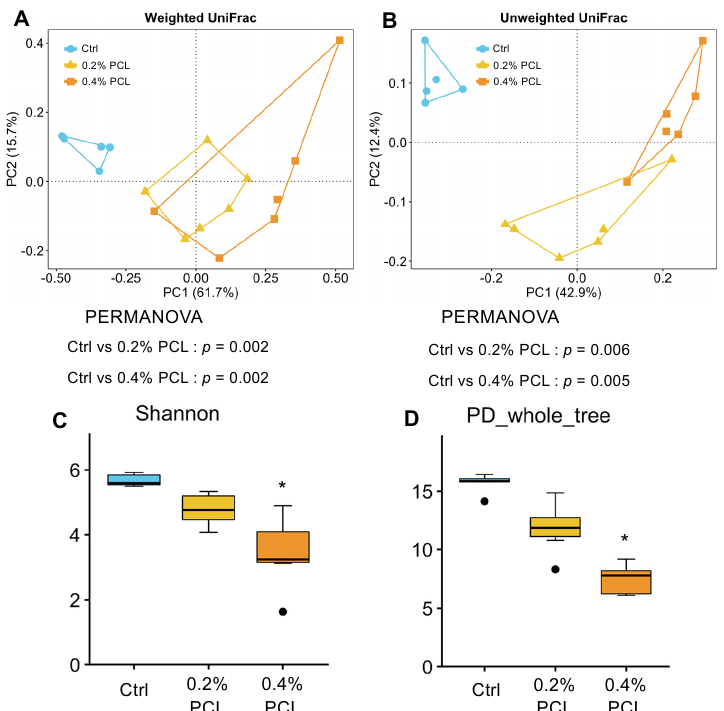
Figure 1. Effects of supplemental PCL on cecal microbiome profiles and alpha diversity. PCoA of unweighted ( A ) and weighted UniFrac ( B ) and PERMANOVA analysis were performed to compare the gut microbiome profiles of the experimental groups. The alpha diversity of the gut microbiota within samples was measured by ( C ) Shannon index and ( D ) PD whole tree. Data are presented as a boxplot with median and min–max whiskers. The dots ( • ) in the boxplots are outliers. * p < 0.05 means significantly different when compared to the Ctrl group (Dunnett’s